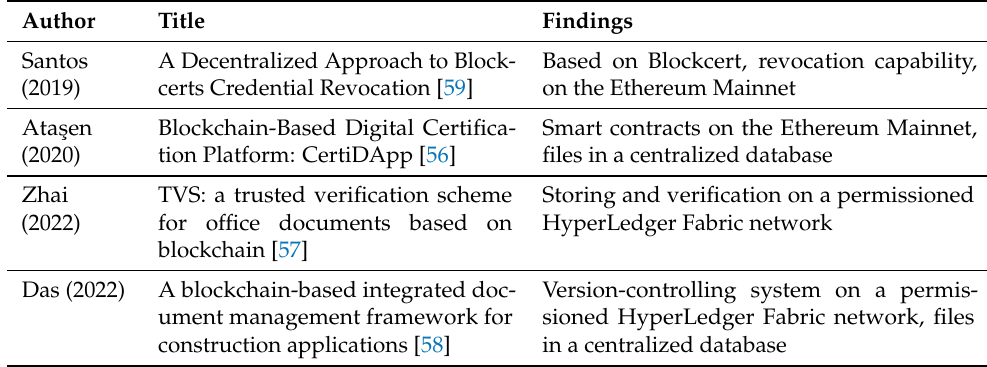
Table 4. Data management summary table.